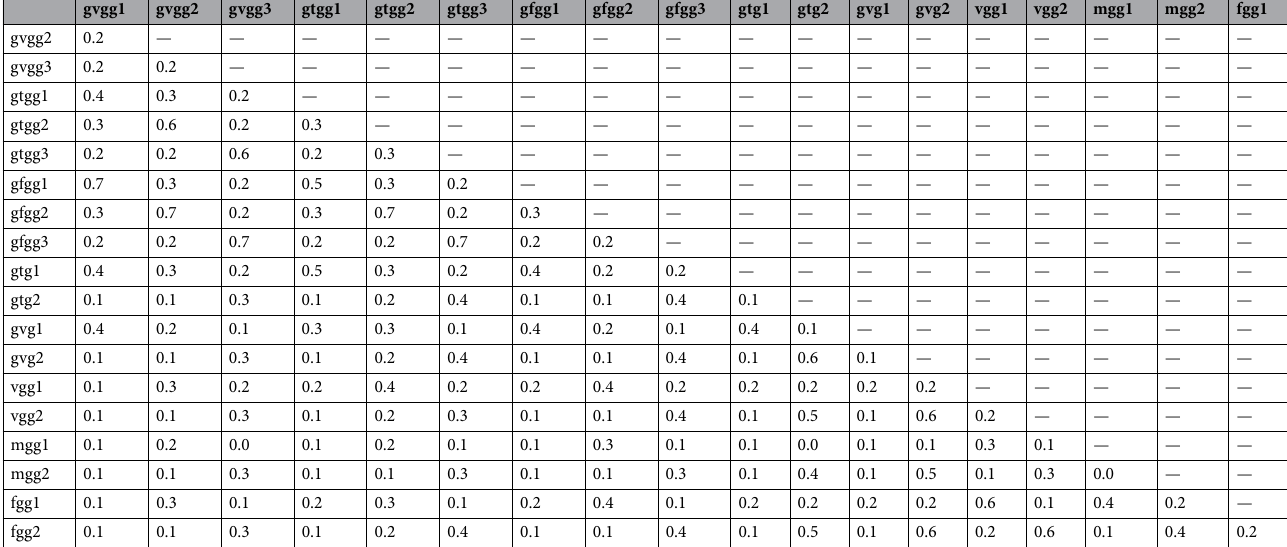
Table 1. The matrix of “error rate” for different ϕ - ψ units. See Fig. 1 for the notions of ϕ - ψ units.